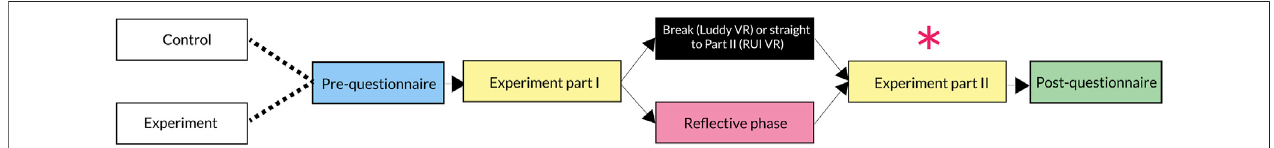
TABLE 1 | Side-by-side comparison of RUI and Luddy VR user studies. Setups (VR/Desktop) Visualization types Map, graph Scale of reference system Graphic variables Position, color hue, size, velocity Interactions Filter, navigate, link and